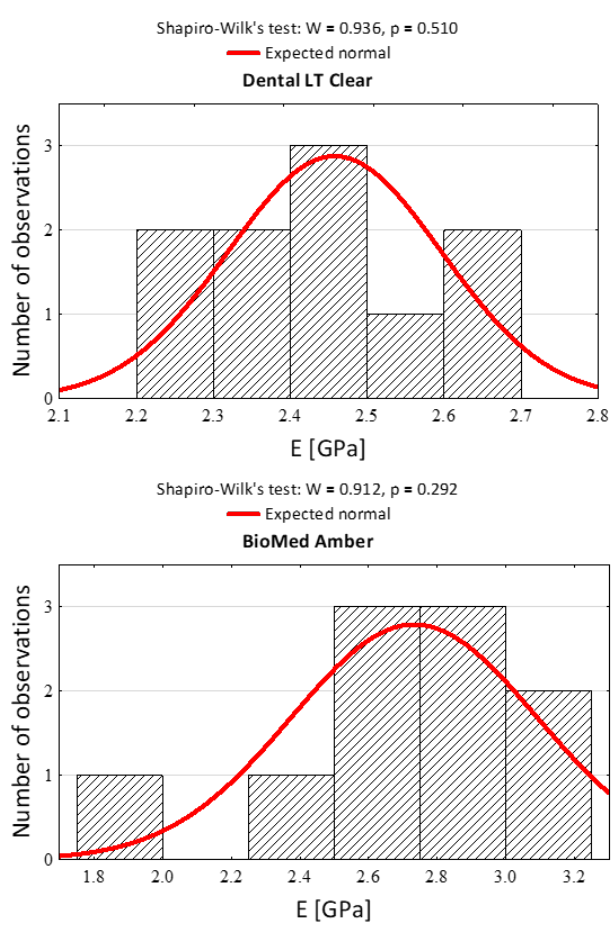
Figure 3. Histograms of the results of Young’s modulus in compression against the background of the normal distribution for three dental materials and the results of normality tests.